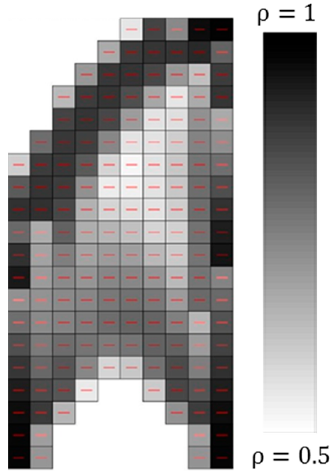
Figure 15. Topology result for Case 3 (front view). Elements with 𝜌 (cid:3032) ≤ 0.5 are not shown.